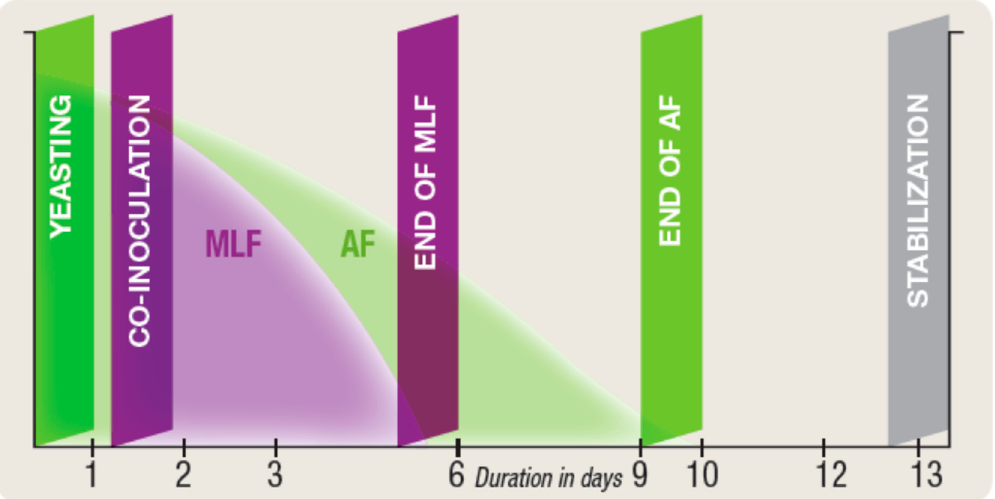
Figure 4. Vinification with a new generation starter culture of Lactobacillus plantarum.